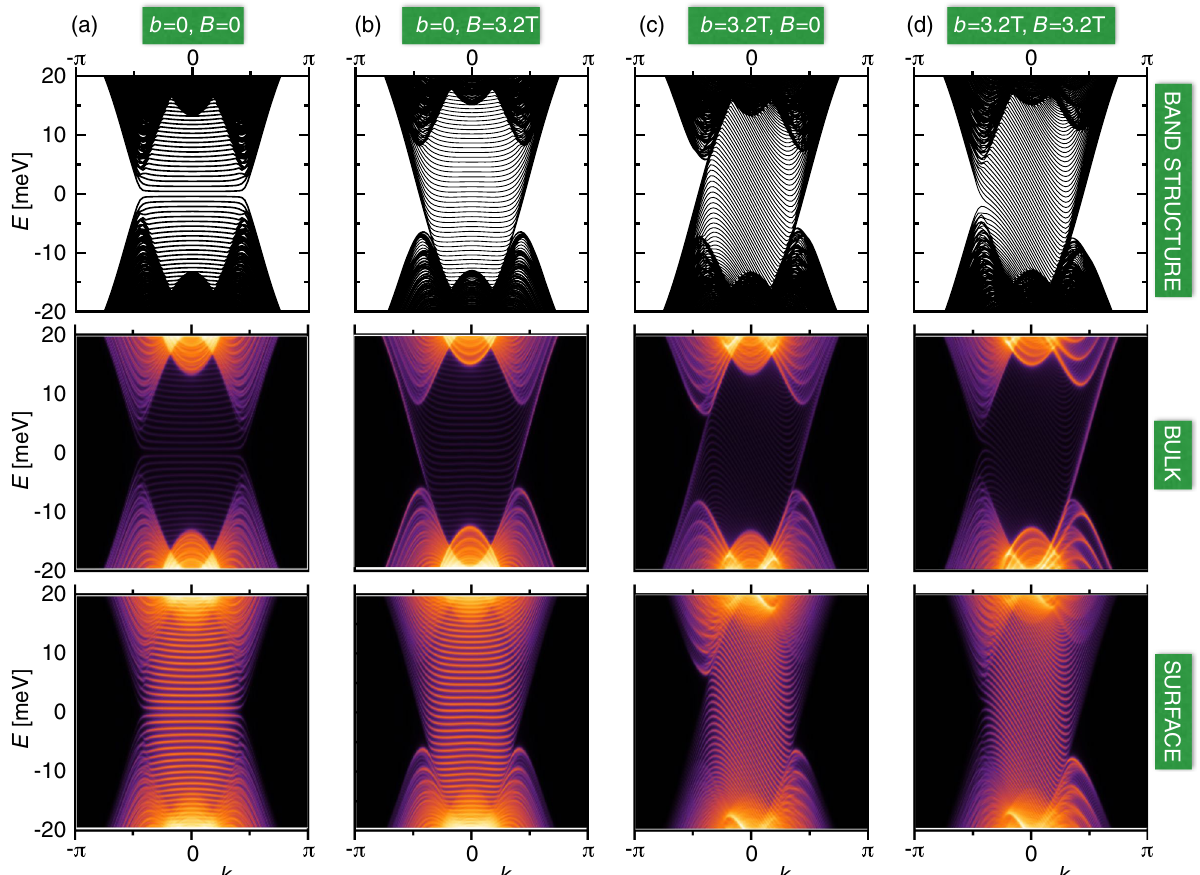
FIG. 3. Tight-binding model simulations of a Weyl semimetal wire under torsional strain and applied magnetic field B ¼ ˆ zB . The top -Cd 3 As 2 model row of figures shows the band structure of the lattice Hamiltonian defined by Eqs. (2.4) and (2.9) computed for 1 2 parameters, for a wire with a rectangular cross section of 30 × 30 sites and a lattice constant a ¼ 40 Å. (We use a larger lattice constant here and in subsequent simulations than in real Cd 3 As 2 in order to be able to model nanowires and films of realistic cross sections with available computational resources. Note that this does not affect the physics at low energies because the lattice Hamiltonian is designed to reproduce the relevant k · p theory independent of a .) Open boundary conditions are imposed along x and y , periodic along z . Parameters appropriate for Cd 3 As 2 are used. The middle and bottom rows show spectral functions A bulk ð k ; ω Þ and A surf ð k ; ω Þ . The ð k ; ω Þ over sites j in the central 10 × 10 portion of the wire, while the latter former is obtained by averaging the full spectral function A j averages over the sites located at the perimeter of the wire. The torsion applied in columns c and d corresponds to the maximum displacement at the perimeter of 0 . 5 a , or φ 0 ≃ 2 o between consecutive